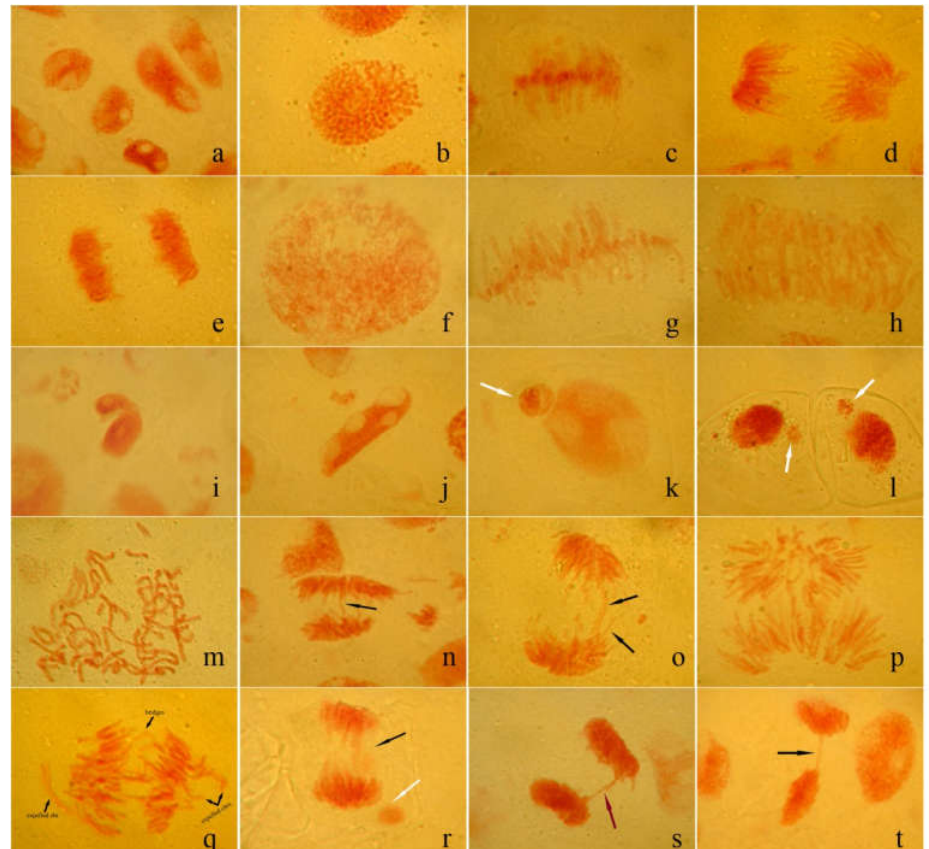
Figure 7. Normal and aberrant mitosis in Triticum aestivum L. root meristem cells after SOBP treatment. ( a – e ) normal inter-, pro-, meta-, ana- and telophase; ( f – h ) giant pro-, meta- and anaphases; ( i ) comma shaped interphase; ( j ) torpedo shaped interphase; ( k , l ) micronuclei with different sizes (white arrows); ( m ) C-metaphase; ( n ) A-T with single bridge (black arrow); ( o ) A-T with two bridges (each black arrow); ( p ) disaster shaped anaphase and multiple bridges; ( q ) complex aberration (A-T with bridges and expelled chromosomes); ( r ) late anaphase with bridges (black arrow) and micronucleus (white arrow); ( s ) overlap chromatids (red arrow); ( t ) telophase with single bridge (black arrow). From